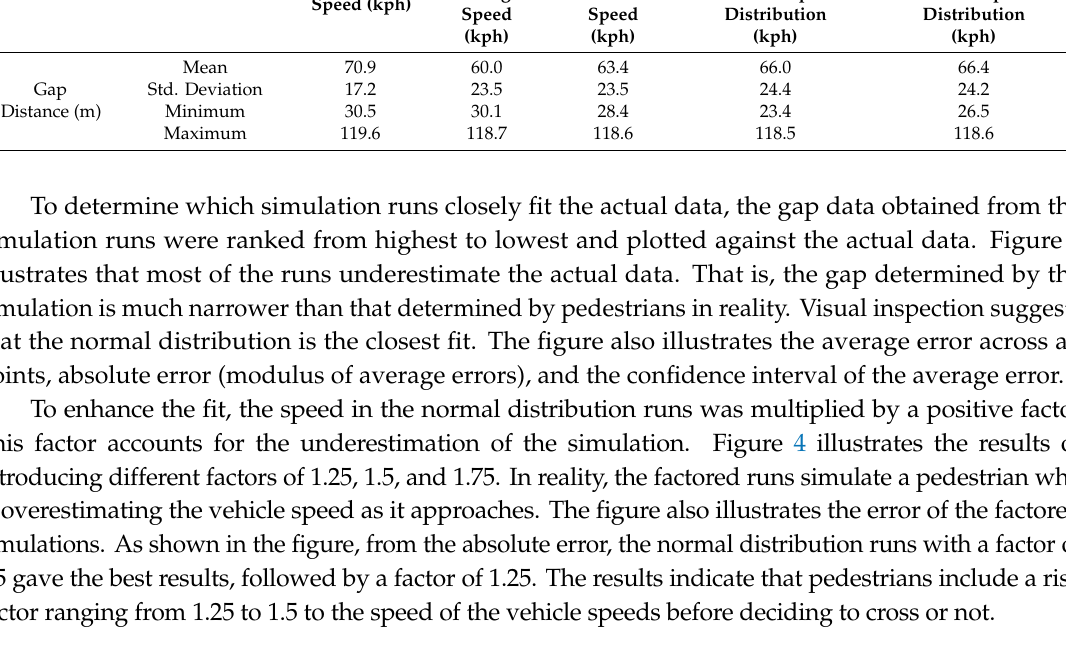
Table 2. Descriptive statistics for the gap distance acquired from actual data and simulation results.